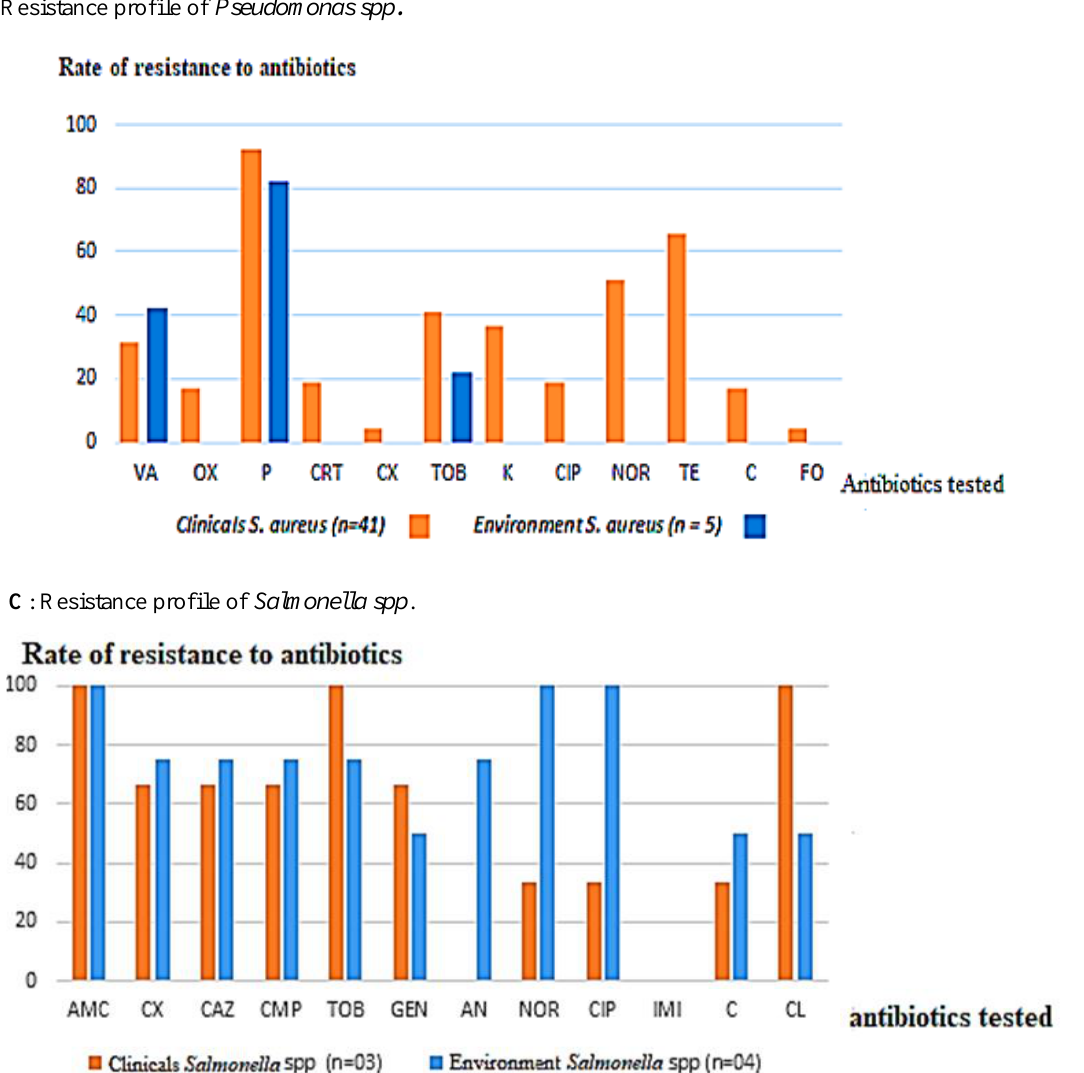
B : Resistance profile of Pseudomonas spp.